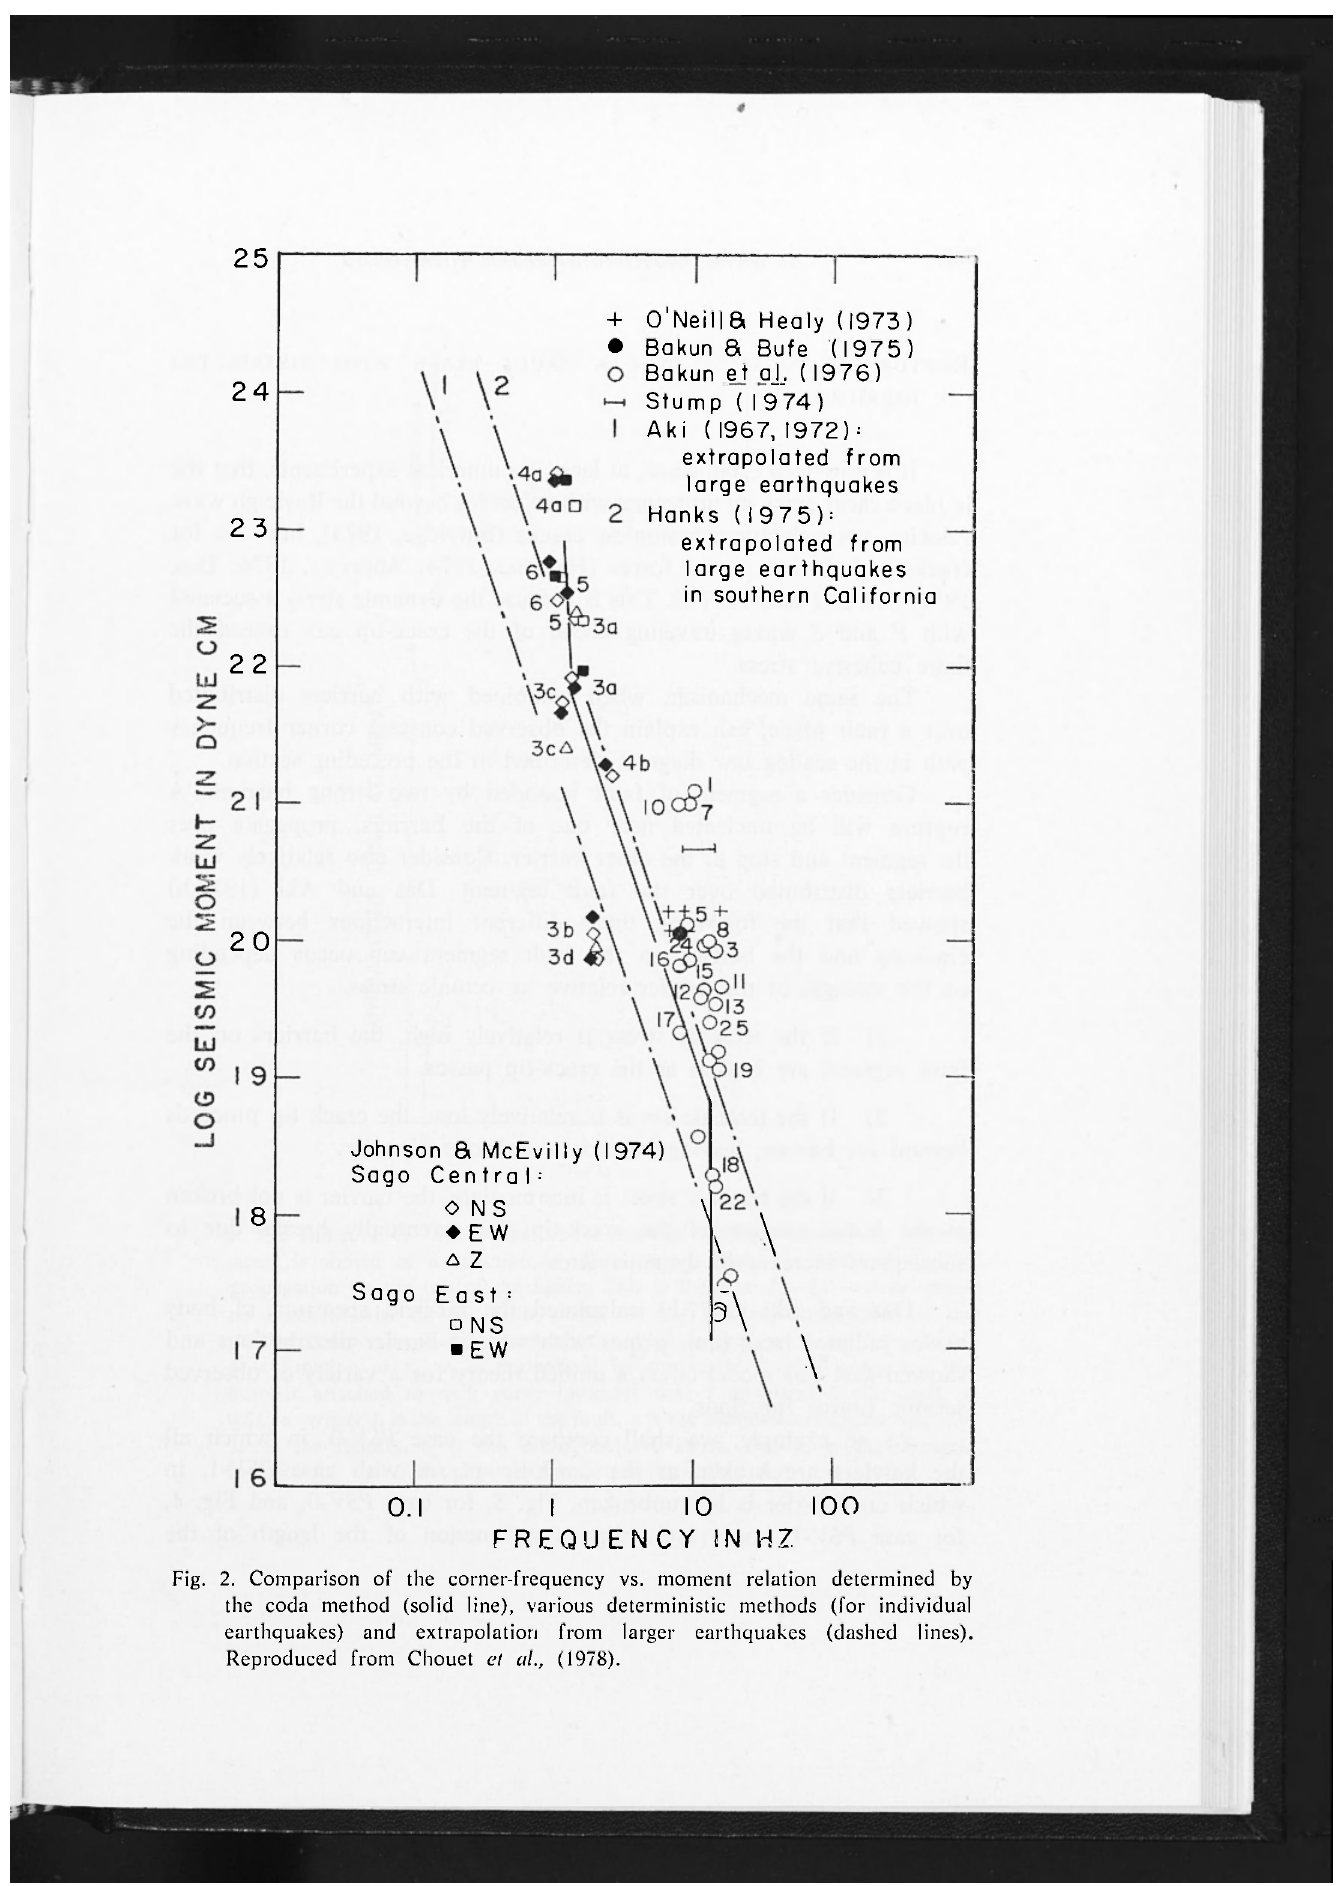
Fig. 2. Comparison of the corner-frequency vs. moment relation determined by the coda method (solid line), various deterministic methods (for individual earthquakes) and extrapolation from larger earthquakes (dashed lines). Reproduced from Chouet el ill.,